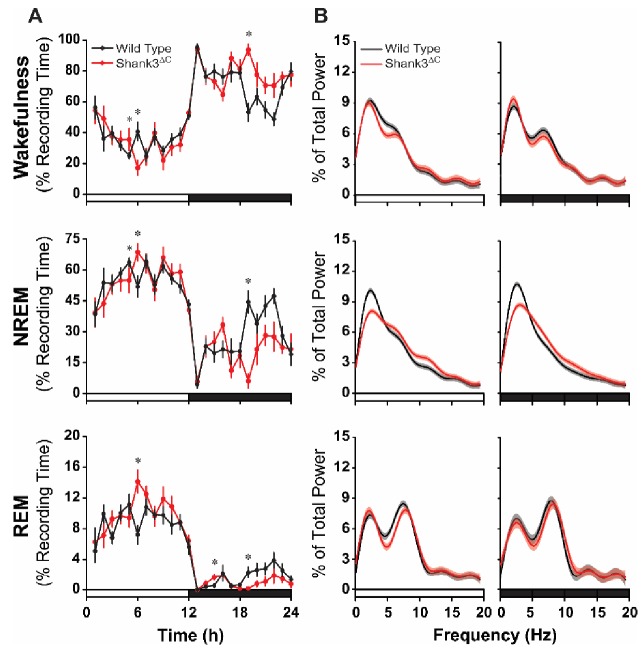
Shank3∆C mice sleep less during the dark period and show altered EEG spectral power under baseline conditions.The rows represent the vigilance states of wakefulness (top), NREM sleep (middle), and REM sleep (bottom). (A) Time spent in wakefulness and sleep shown as percentage of recording time per hour. Values are means ± SEM. Repeated measures ANOVA with posthoc pairwise comparisons using Sidak correction; *p<0.05, difference from wild type. (B) EEG spectral power normalized as a percentage of the total state-specific EEG power for the light period (left) and dark period (right) fit to smooth curves (solid lines) and expressed with 95% confidence intervals (gray and red shading). Non-overlap of the 95% confidence interval denotes statistically significant differences. The open bars on the x-axis denote the light period and the filled bars denote the dark period of the light:dark cycle. Wild type (n = 10) and Shank3∆C (n = 10) mice.
10.7554/eLife.42819.007Figure 2—source data 1.Source data and summary statistics used for generating plots for Figure 2.

10.7554/eLife.42819.008Figure 2—source data 2.Statistical results for Figure 2 and Figure 2—figure supplement 1. numDF, numerator degrees of freedom. denDF, denominator degrees of freedom.